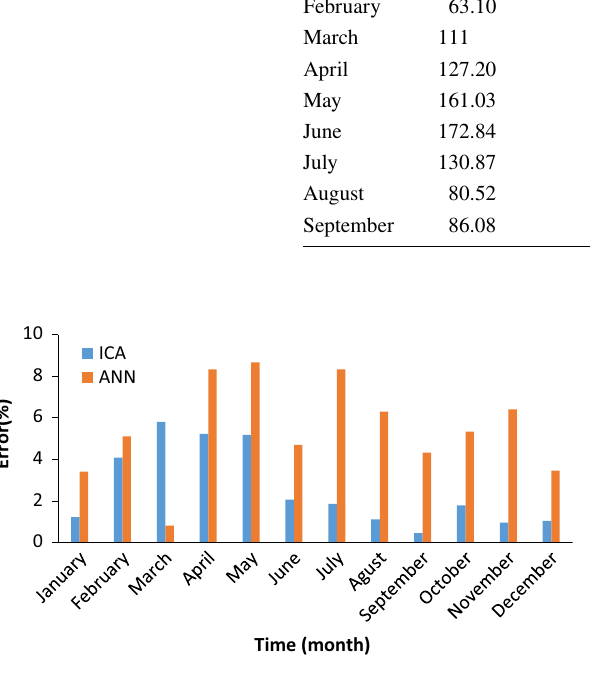
Table 7 The optimal storage capacity and the relevant outflow obtained by ICA and ANN models for Shaharchay dam